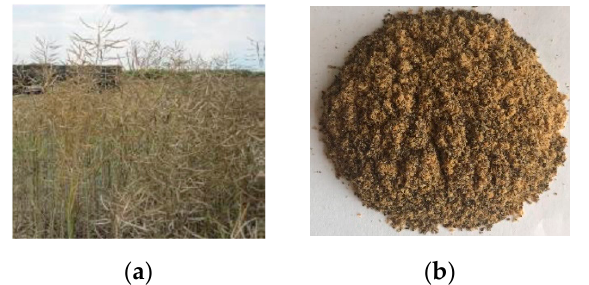
Figure 1. Residual rapeseed biomass: ( a ) gross residual rapeseed biomass (straw, leaves, and pods); ( b ) residual rapeseed biomass having particle size of 0.5